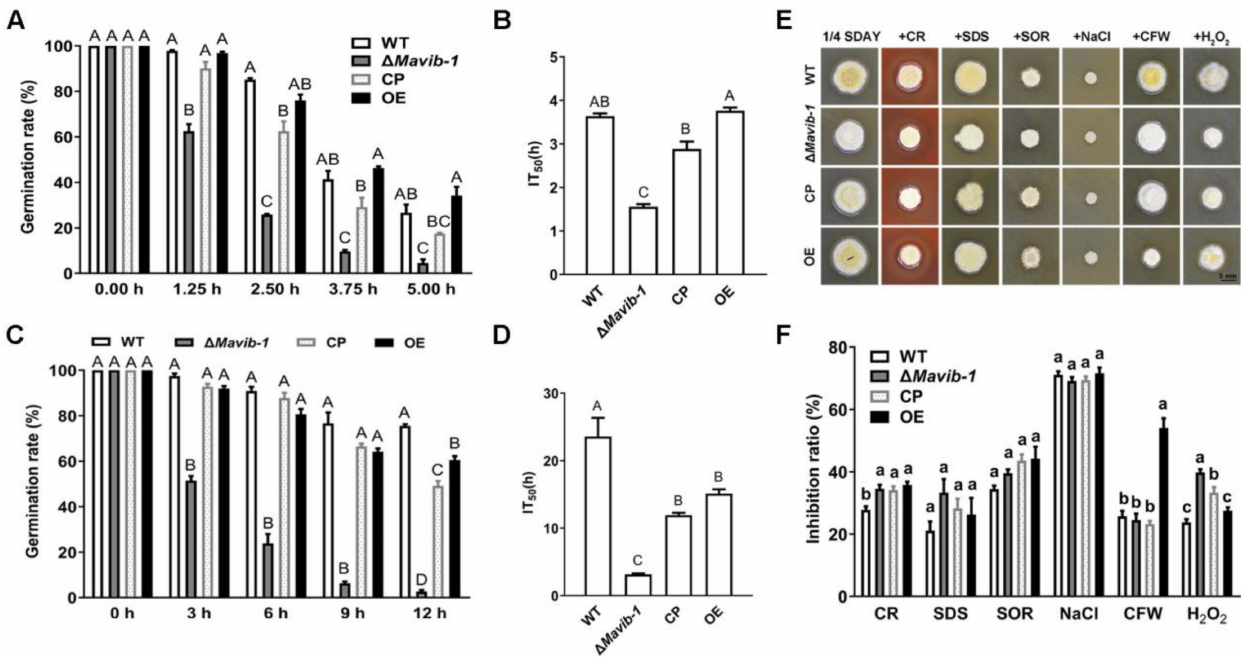
Figure 2. Stress tolerances of conidia from WT, ∆ Mavib-1 , CP and OE strains. ( A ) Germination rate of each strain on 1/4 SDAY media at 28 ◦ C for 20 h after UV-B stress treatment at 0, 1.25, 2.5, 3.75, 5.0 h. ( B ) The half inactivity time (IT 50 ) of each strain with UV-B treatment. ( C ) Germination rates on 1/4 SDAY at 28 ◦ C for 20 h after 46 ◦ C heat stress treatment at 0, 3, 6, 9, 12 h. ( D ) The IT 50 of WT, ∆ Mavib-1 , CP and OE strains under 46 ◦ C heat treatment. ( E ) The fungal colony on 1/4 SDAY medium and 1/4 SDAY with cell wall disruptors (500 µ g/mL CR, 50 µ g/mL CFW), cell wall stressor (0.01% SDS), hyperosmotic stressors (1 mol/L SOR or 1 mol/L NaCl), oxidative stress (6 mmol/L H 2 O 2) , respectively. ( F ) Inhibition rate of colony growth. All experiments were repeated three times for statistical analysis. Different capital letters represented significant difference at p < 0.01; different lower-case letters represented significant difference at p <